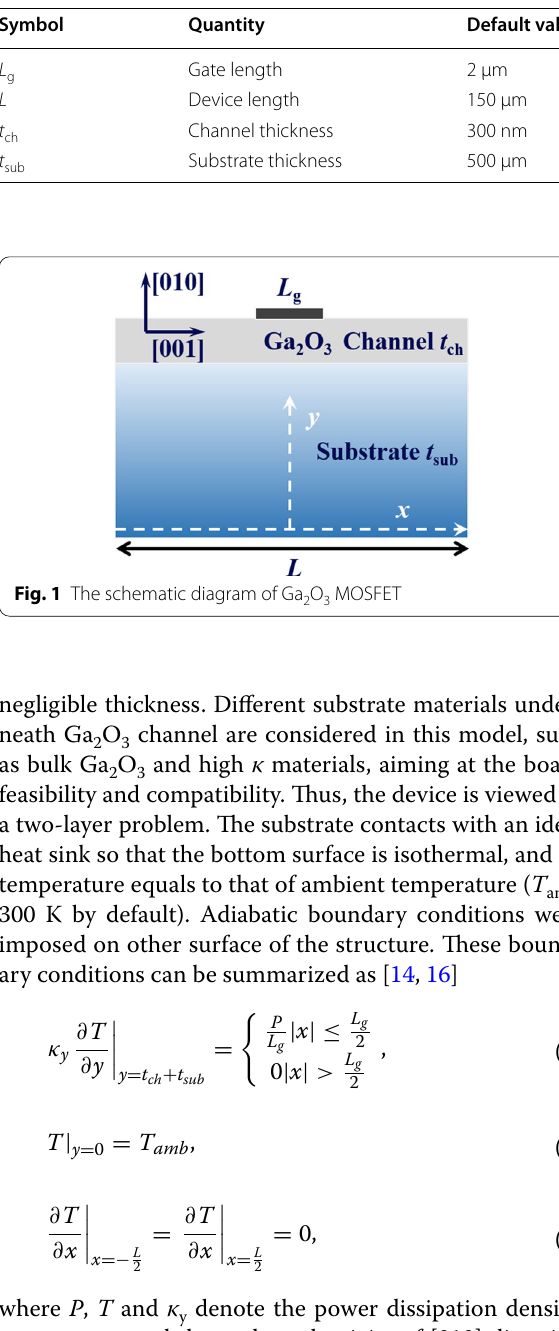
Table 1 Key parameters of structure